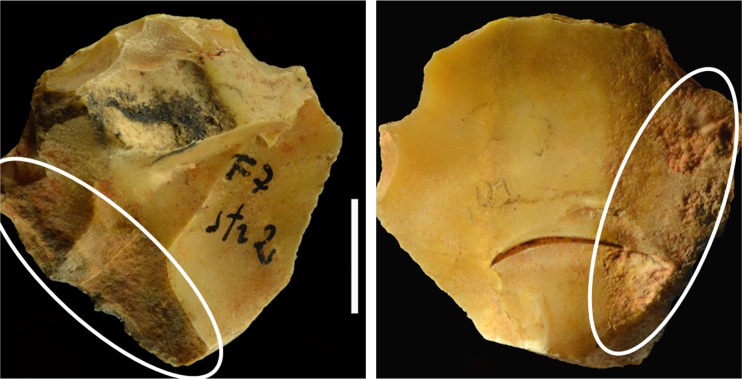
End scraper from layer 2, square F7 with hafting residue and location of sampling for GC/MS (S4 File).